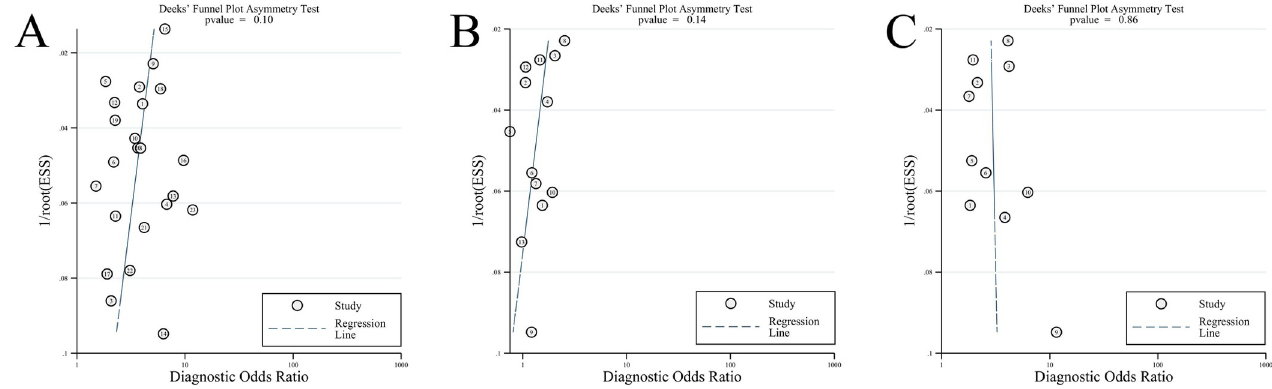
Fig 2. Deek’ s funnel plot for publication bias. A: qSOFA; B: SIRS; C: NEWS.